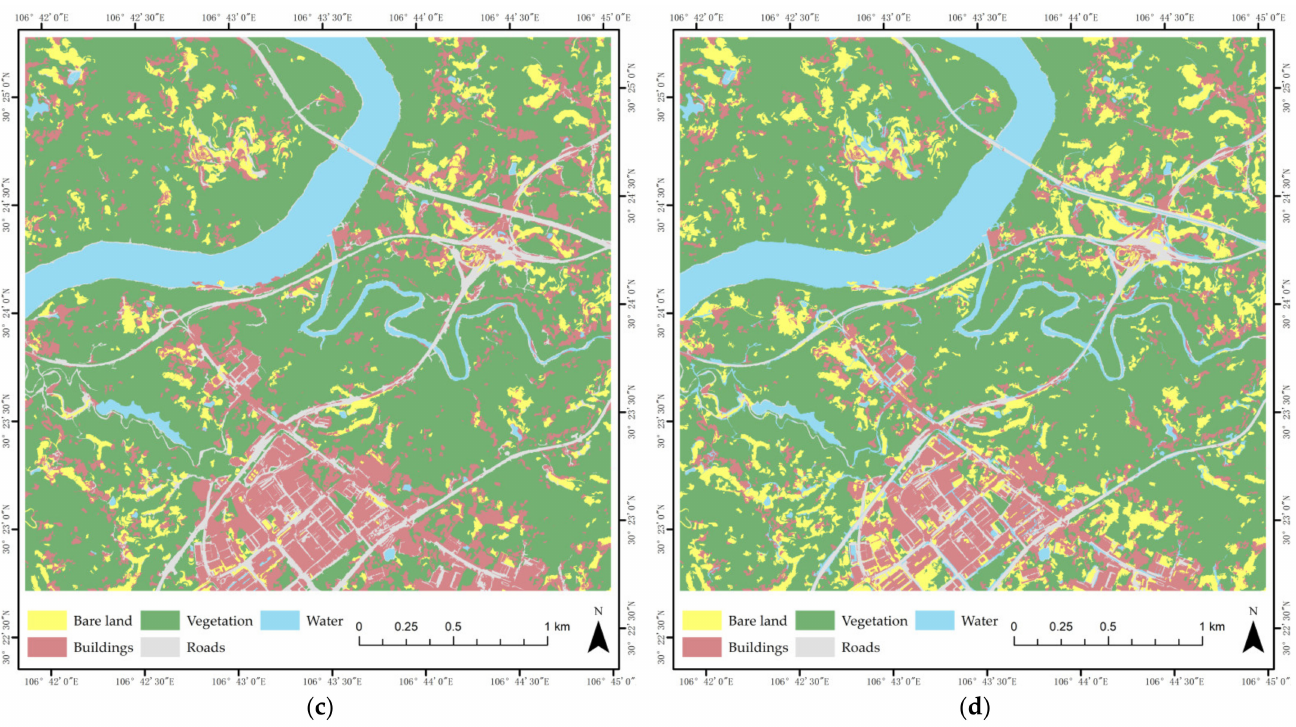
Figure 8. Fm classification image with different classifiers: ( a ) CART; ( b ) RF; ( c ) KNN; ( d ) SVM.